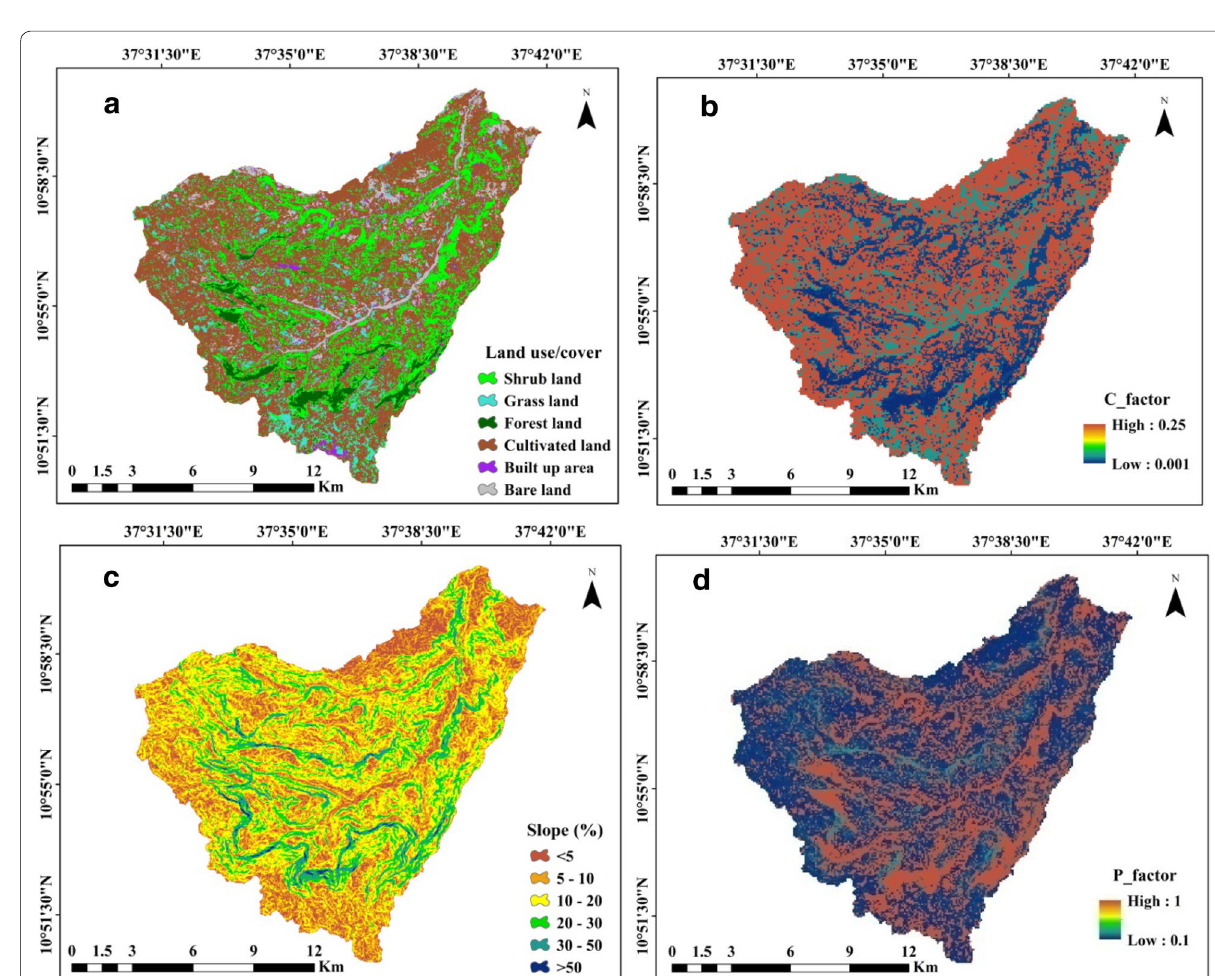
Fig. 3 Map showing a land use/cover, b C-factor, c slope in percent, d P-factor for Gumara